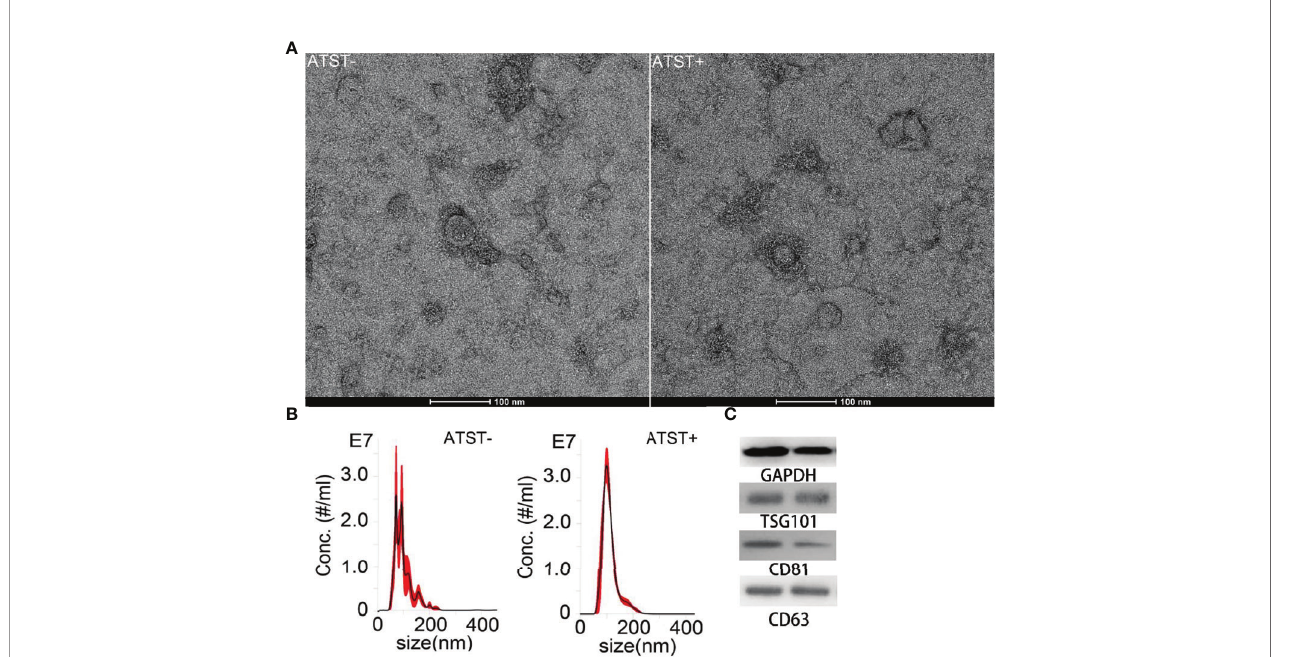
FIGURE 3 | EVP characterization. (A) TEM image of EVP derived from cells treated or untreated with atorvastatin (scale bar is 100 nm). (B) Size distribution of EVPs derived from cells treated or untreated with atorvastatin. (Left: Atorvastatin- (ATST-) EVPs; Right: ATST+ EVPs). (C) Western blotting analysis of EVPs derived from cells treated (right) or untreated (left) with